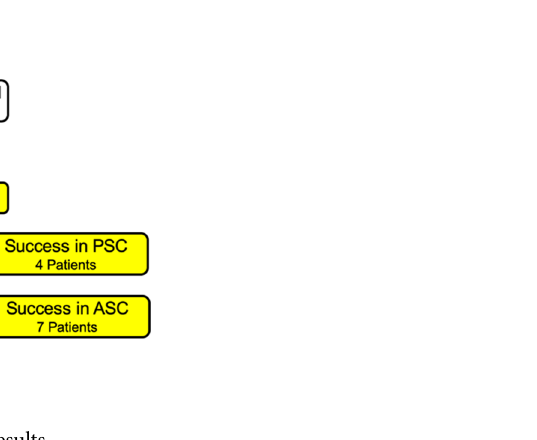
Figure 1. Flow chart of mapping and ablation